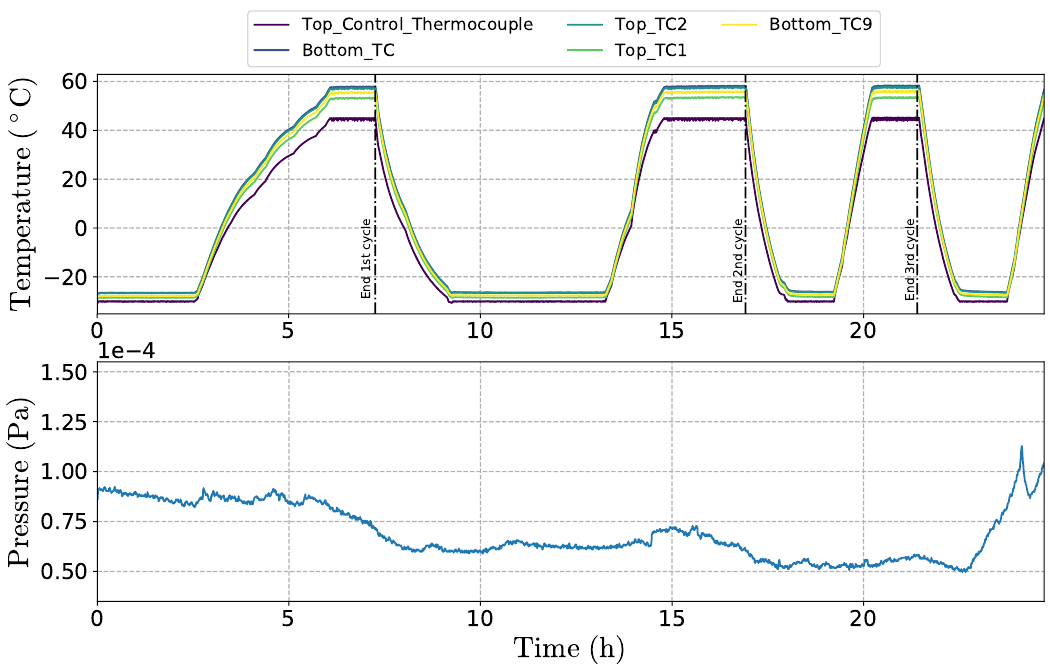
Figure 10. Temperatures measured by thermocouples located on the unit obtained during TVAC qualification of SMIC. The pressure in the chamber throughout the test, which was always lower that 1.0 × 10 − 4 Pa, is also shown.